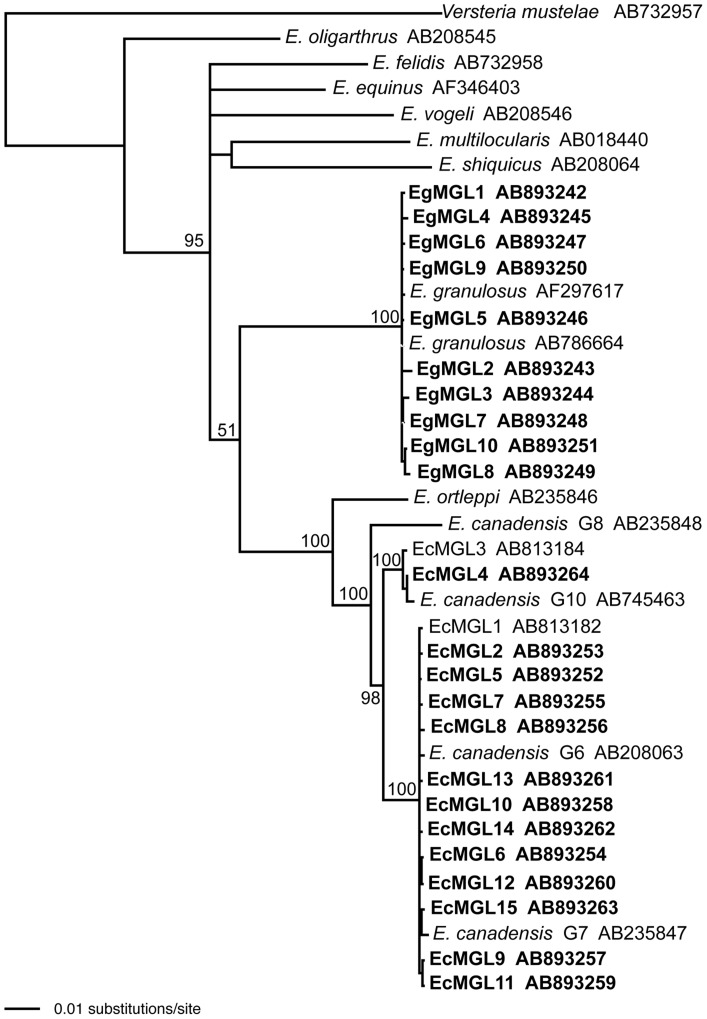
A neighbour-joining tree of Echinococcus spp. constructed from the nucleotide sequences of mitochondrial cox1 gene.Numbers on the nodes are bootstrap values. The names of the haplotypes obtained in this study are shown in bold.